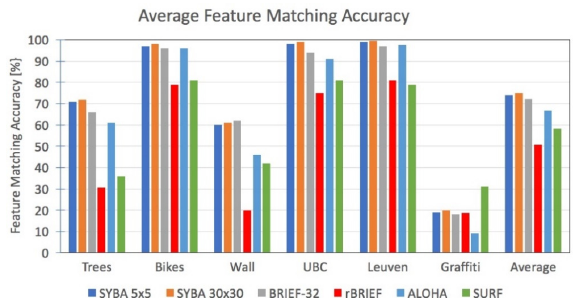
Figure 1. Comparison of SYnthetic BAsis (SYBA) to other feature descriptors. This chart is a summarized version of previous work from Reference [11].